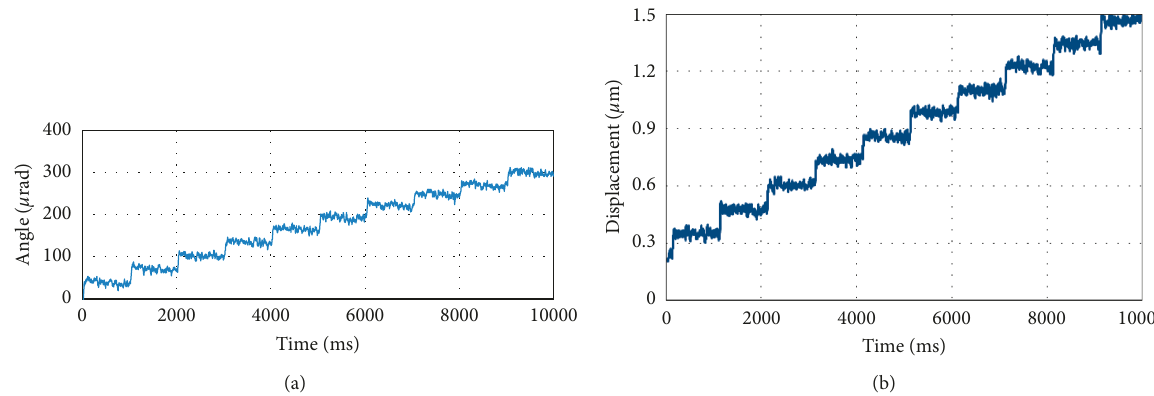
Figure 16: Measured stepped rotation (a) and translation (b) of the mirror using the burst-type harmonic